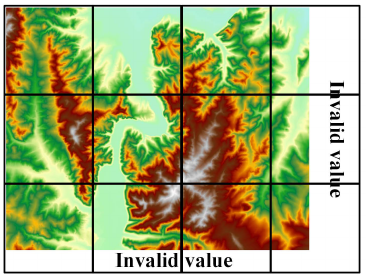
Figure 6. Method of partitioning raster data.